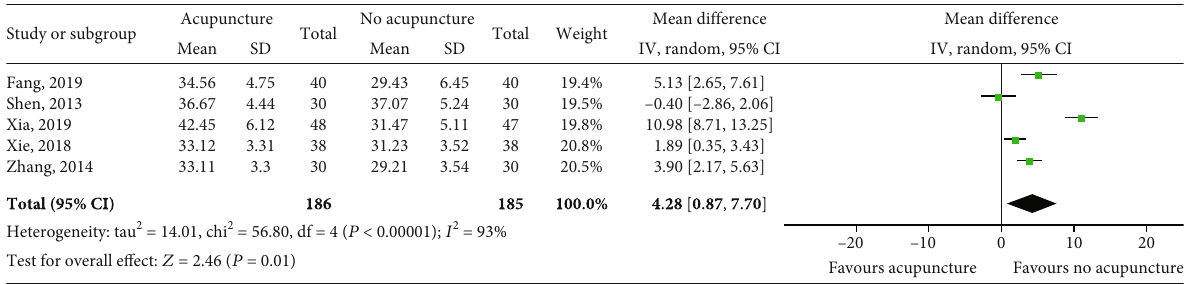
Figure 6: Impact of acupuncture on ALB. Both I 2 and P represent the criteria for the heterogeneity test. ♦ : pooled mean di ff erence; — ■ — : mean di ff erence and 95% CI.